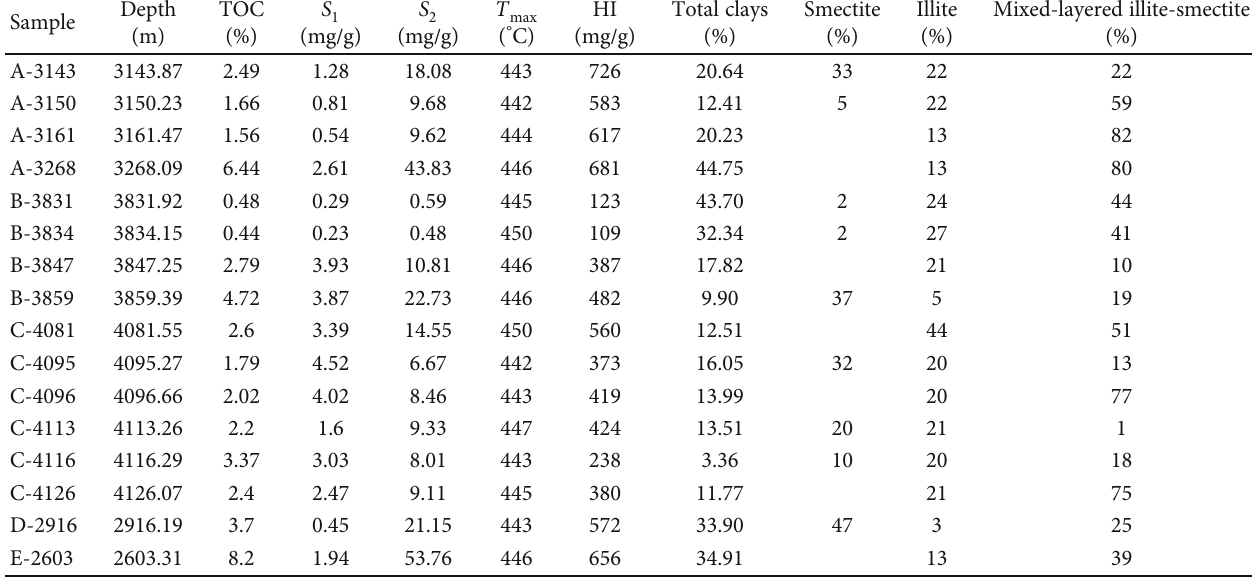
samples employed in this 2